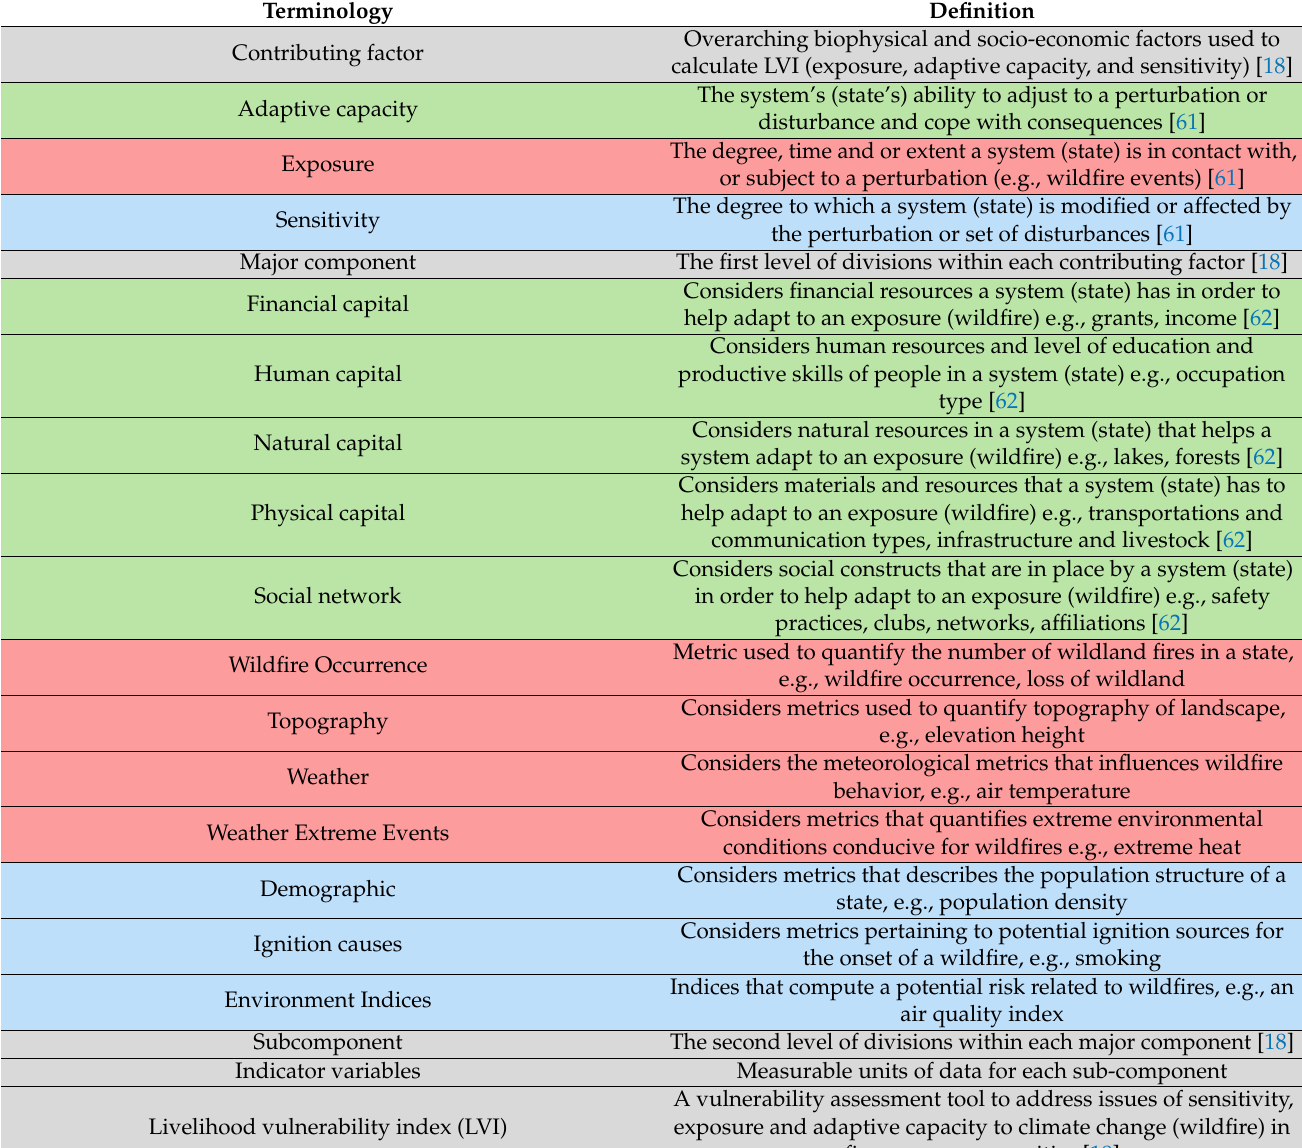
Table A1. LVI terminology definitions, color coordinated by major components in each contributing factor: adaptive capacity (green), exposure (red) and sensitivity (blue). Gray highlights denote terms that are frequently used in livelihood vulnerability